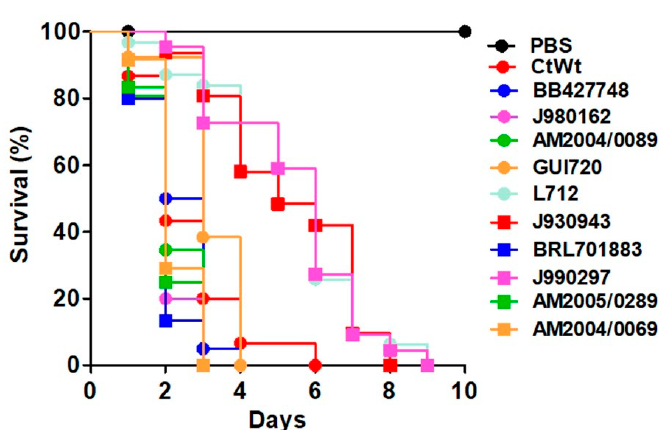
Figure 3. Mortality curves of Galleria mellonella larvae infected with different Candida tropicalis clinical isolates. Each animal group contained 30 larvae (10 larvae for each experiment) and animals were infected with 2 × 10 7 yeast cells. Animal death was defined by extensive body melanization and loss of irritability, parameters that were monitored daily. PBS, control group injected only with PBS. WT, strain MYA-3404. The mortality in animals infected with strains L712, J930943, and J990297 was significantly different from that associated with the other fungal strains ( p < 0.05 in all cases).